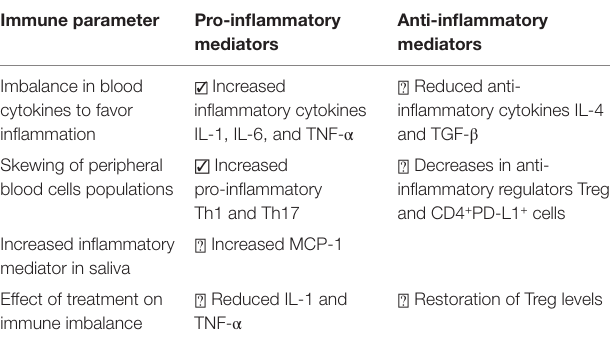
TABLe 1 | Overview of studies with human subjects with PTSD. immune